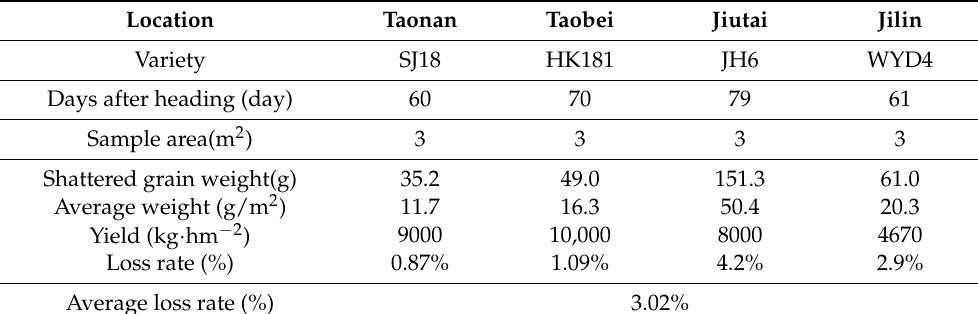
Table 5. Loss rate due to grain shattering.